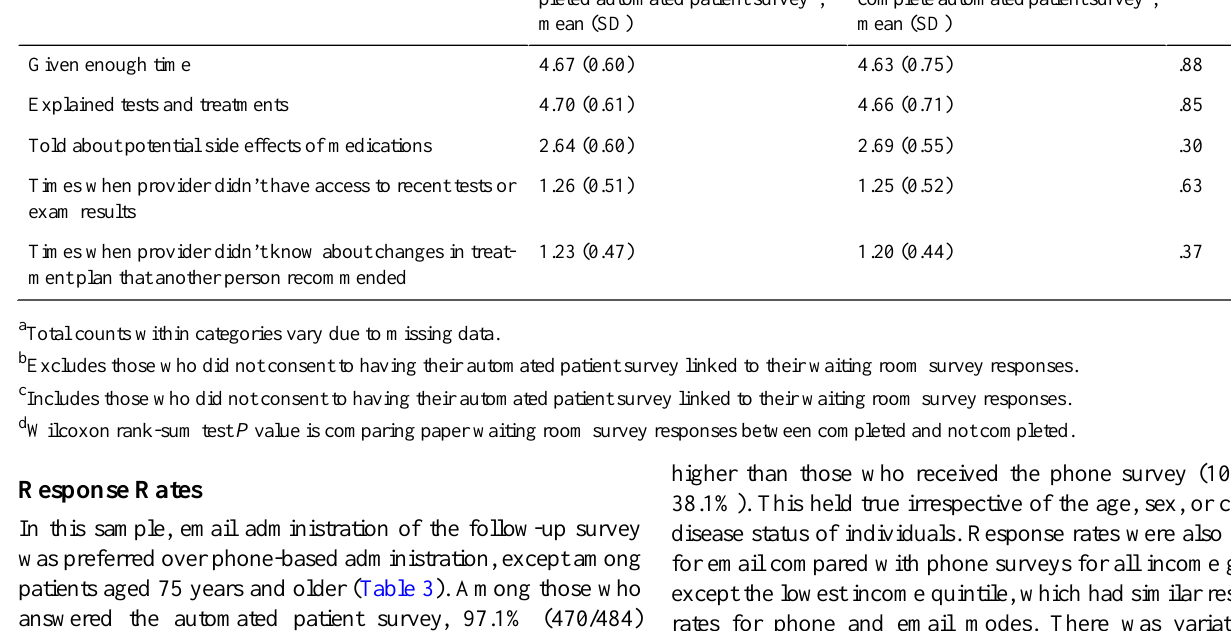
P value d Response for those who did